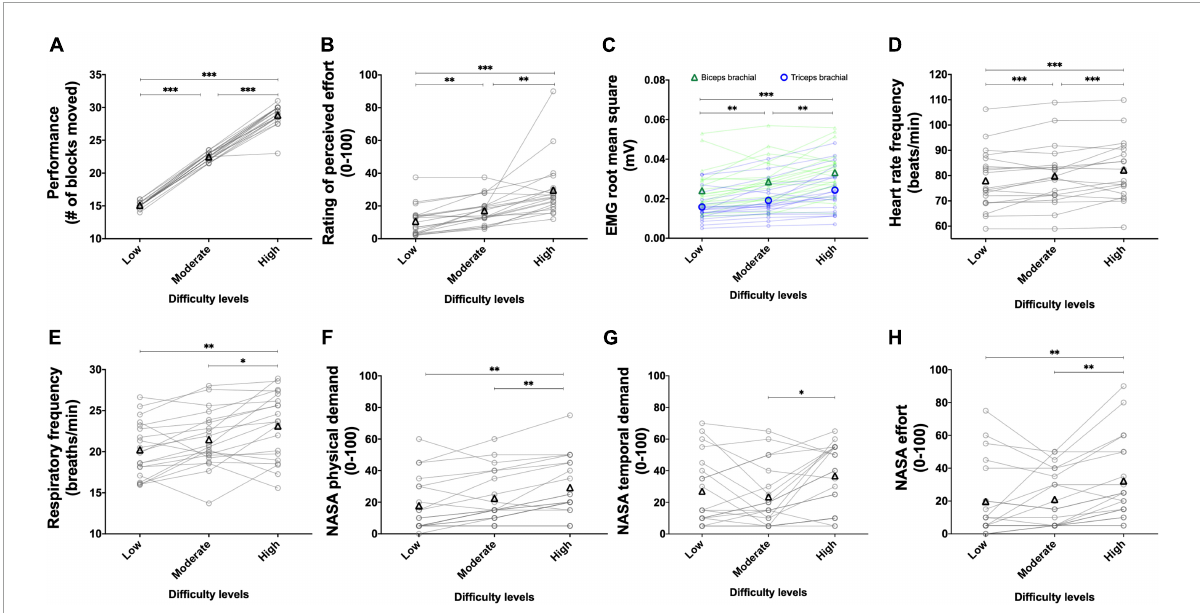
FIGURE5 Experiment 1B: Manipulating the tempo to alter task difficulty during the box and block test. Effect of manipulating the tempo during the box and block test on performance ( A , n = 20), rating of perceived effort ( B , n = 20), EMG root mean square of the biceps (green line) and triceps (blue line) brachial muscles ( C , n = 20), heart rate frequency ( D , n = 18), respiratory frequency ( E , n = 20) and NASA TLX scores for physical demand ( F , n = 20), temporal demand ( G , n = 20), and subjective effort ( H , n = 20). For the low difficulty, a 0.5 Hz tempo was imposed. For moderate difficulty, a 0.75 Hz tempo was imposed. For the high difficulty, a 1 Hz tempo was imposed. Data are presented as the main effect of difficulty, except for panel (C) presenting the difficulty × muscle interaction. The n indicates the number of participants with all the data in each of the three levels of difficulties. Changes in the n reflect data loss due to issues with equipment or movement artifact. Individual data are presented in light markers and means in dark markers. *Main effect of difficulty, the difference between two difficulty levels. * p < 0.05, ** p < 0.01, and *** p <